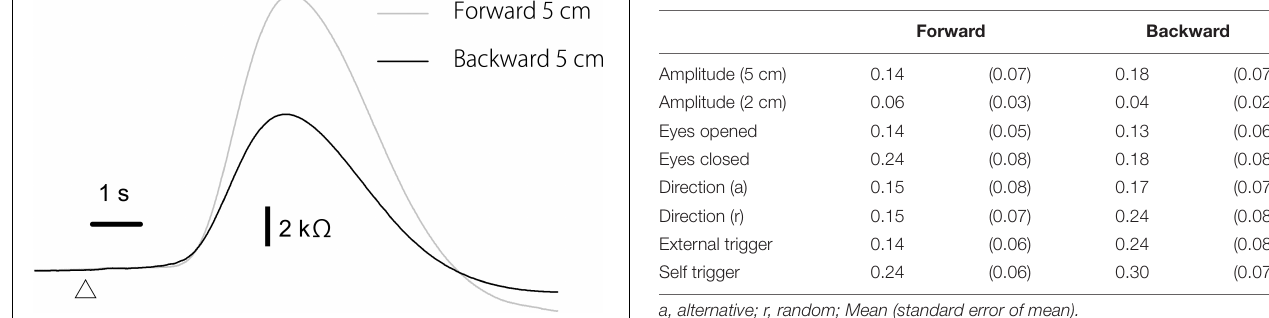
TABLE 7 | Appearance probability of two-peak